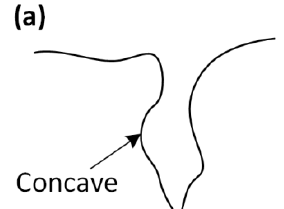
Figure 12. The process of collapsing at the bottom of the keyhole: ( a ) the concave area forms in the middle of the inner wall of the keyhole, ( b ) the concave area becomes smaller in the middle of the keyhole wall, ( c ) the bulge forms in the middle of the keyhole wall, ( d ) collapse of the keyhole bottom and formation of the bubble.